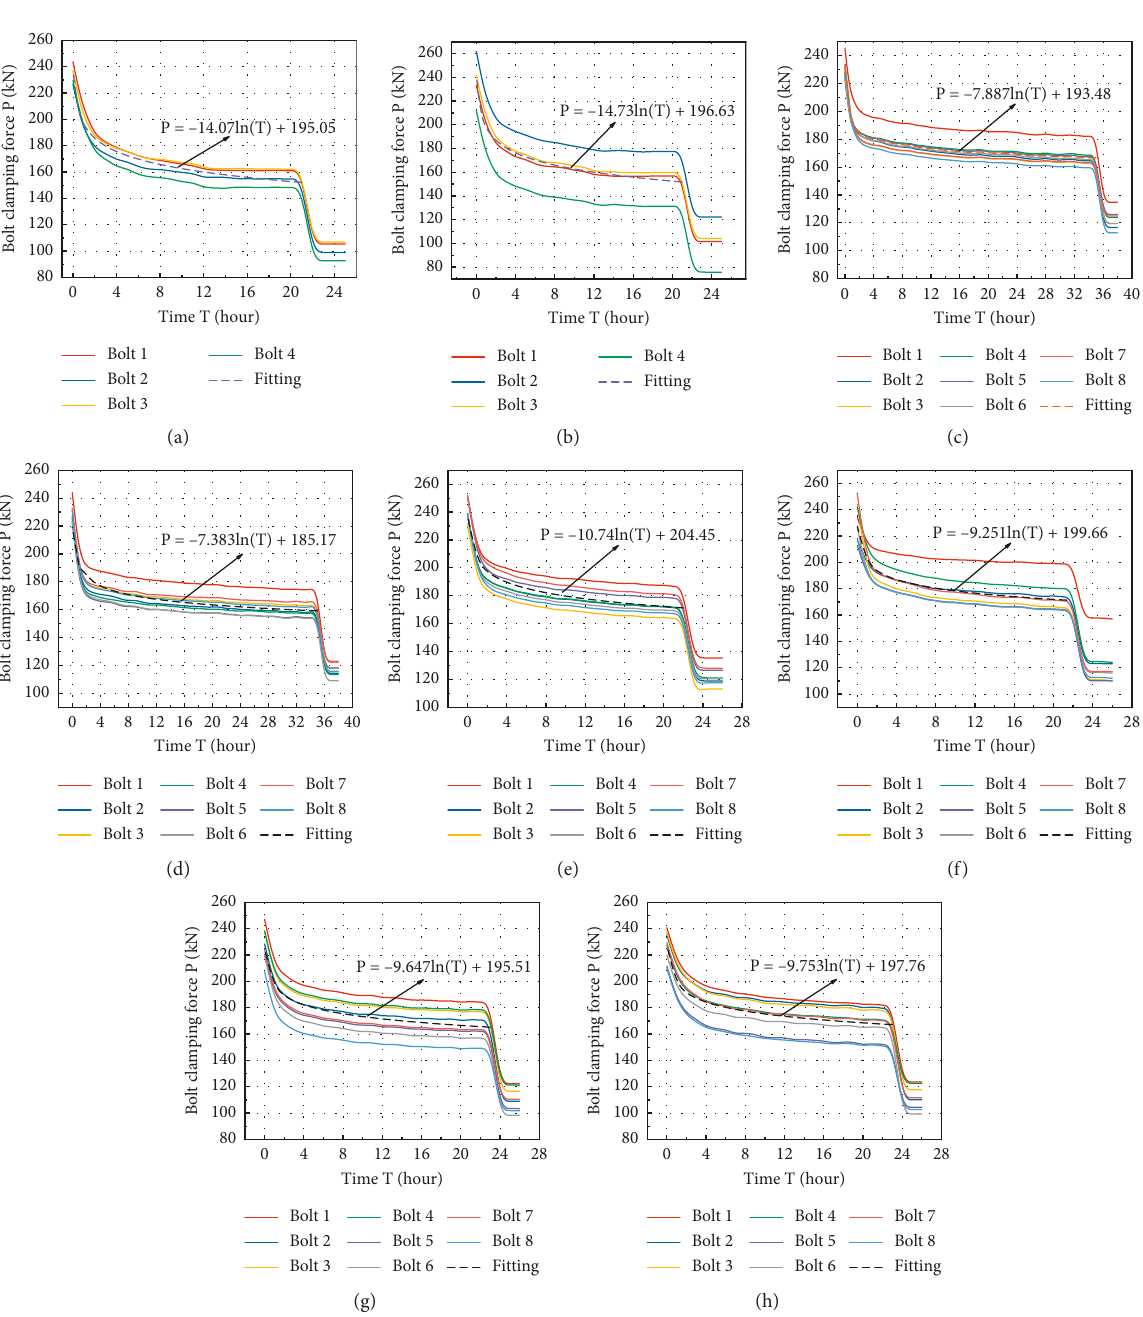
Figure 17: Bolt clamping force creep curves vs. time. (a)